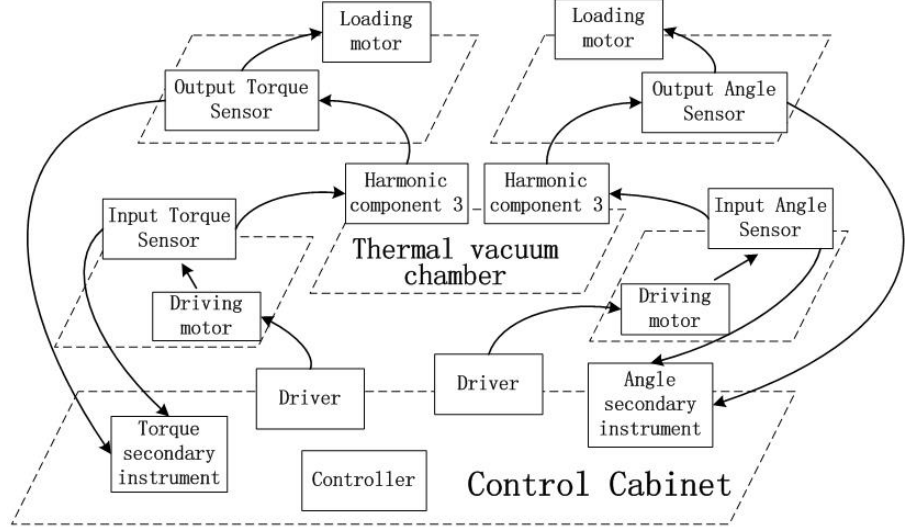
Figure 3. Overall hardware schematic.